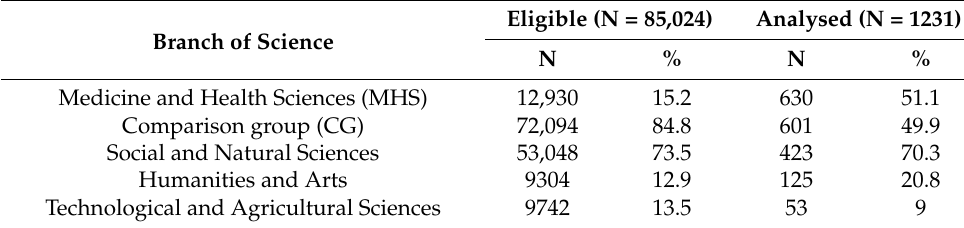
Table 1. The composition of female student-aged population in the